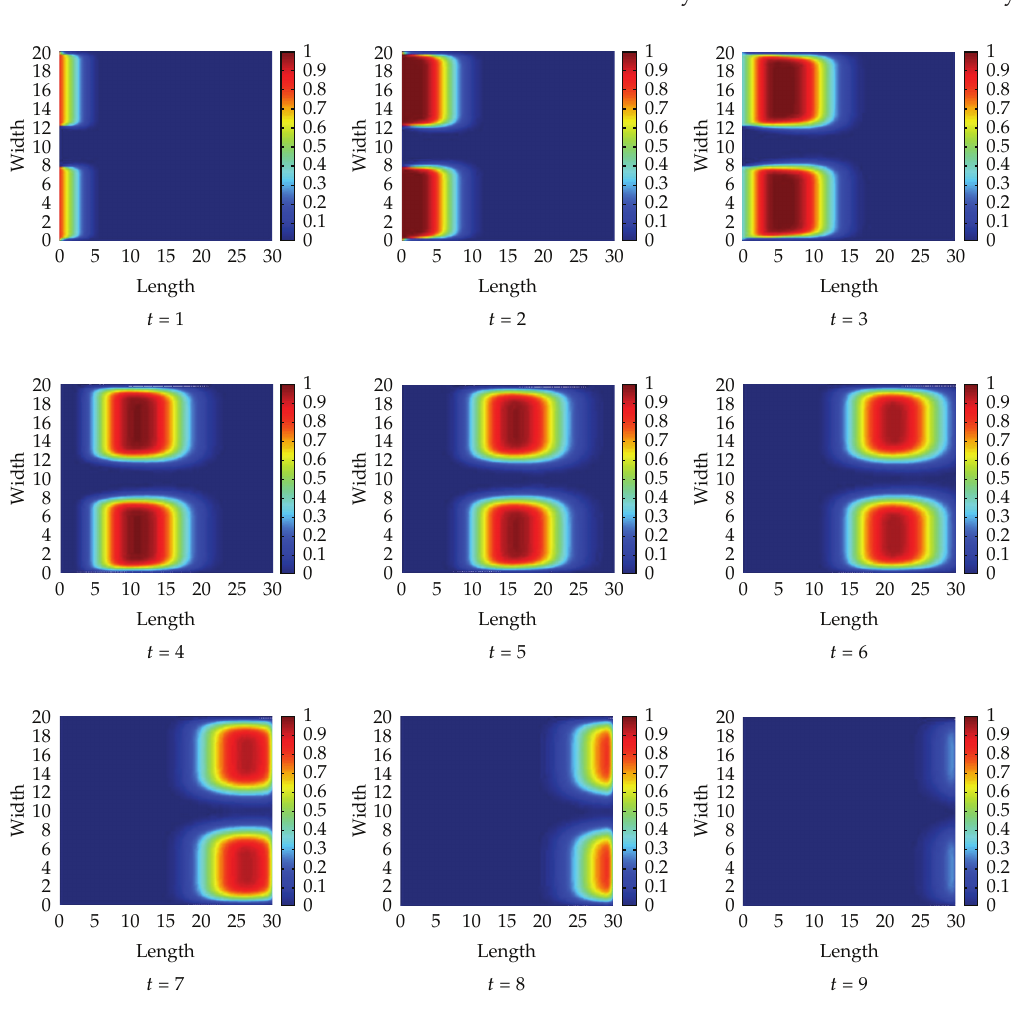
Figure 3: Density of pedestrian flow at di ff erent